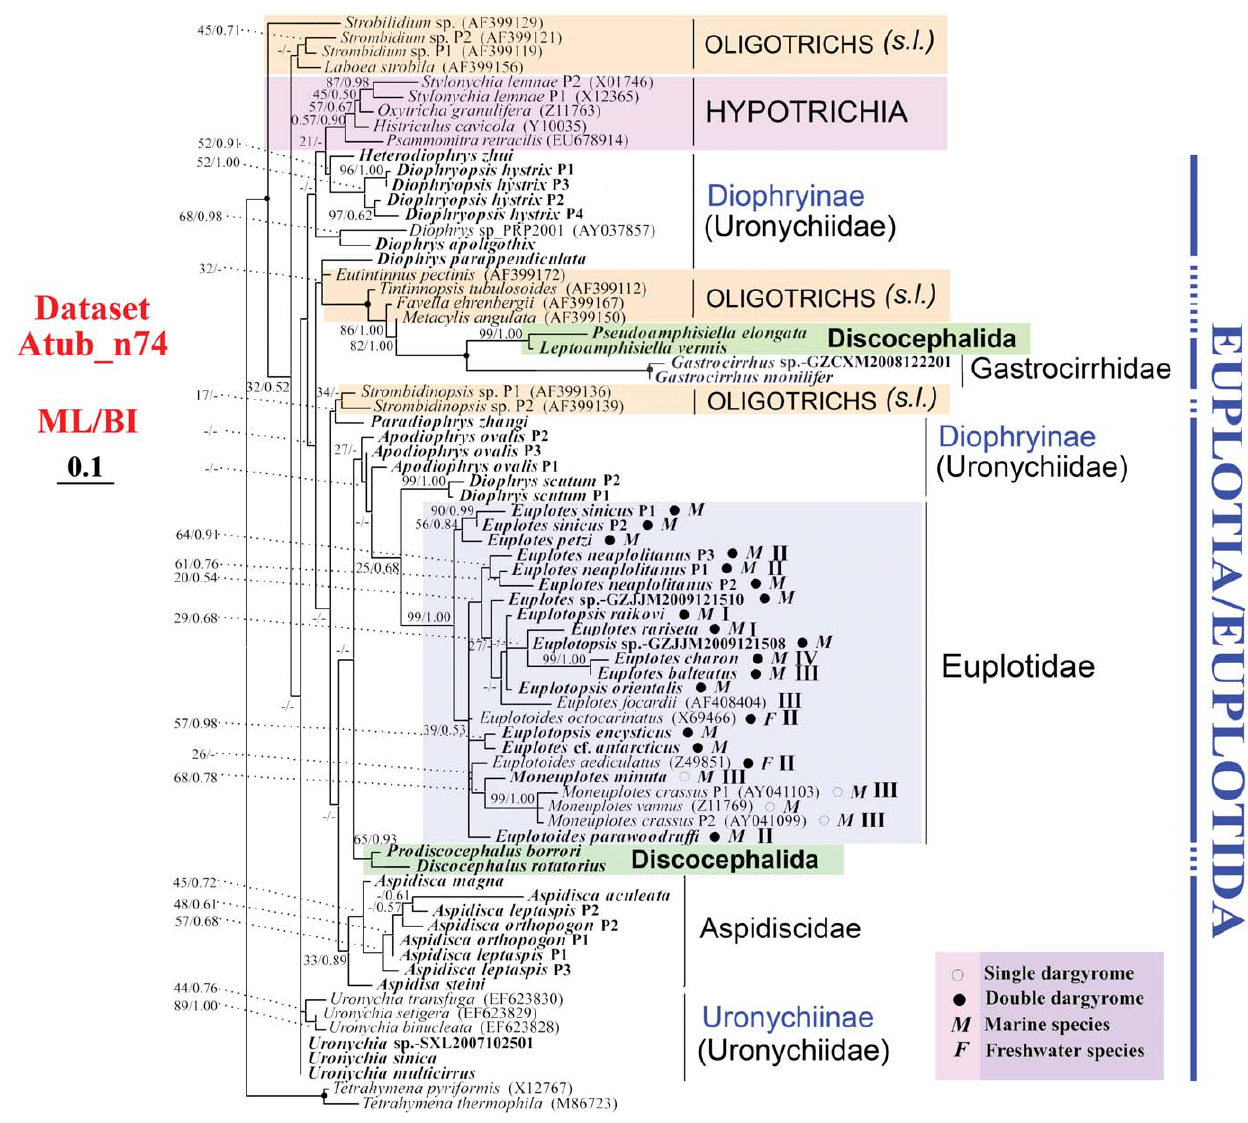
Figure 2. Best tree of the Spirotrichea inferred by Maximum likelihood of Dataset Atub_n74. Species newly sequenced in the present study are shown in bold type. Bootstrap values for branches of the ML tree and posterior probability values for BI tree, respectively, are given on nodes. Fully supported (100%/1.00) branches are marked with solid circles. The scale bar corresponds to 10 substitutions per 100 nucleotide positions. Dargyrome patterns and natural habitats are given after species name of euplotids by symbols. Clades I-IV for euplotids were designated according to Petroni [42] and Yi et al. [38].